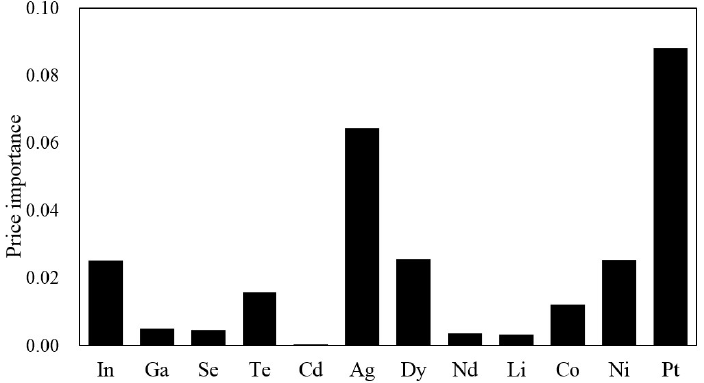
Figure A6. Estimated Price importance in each metal in 2015.